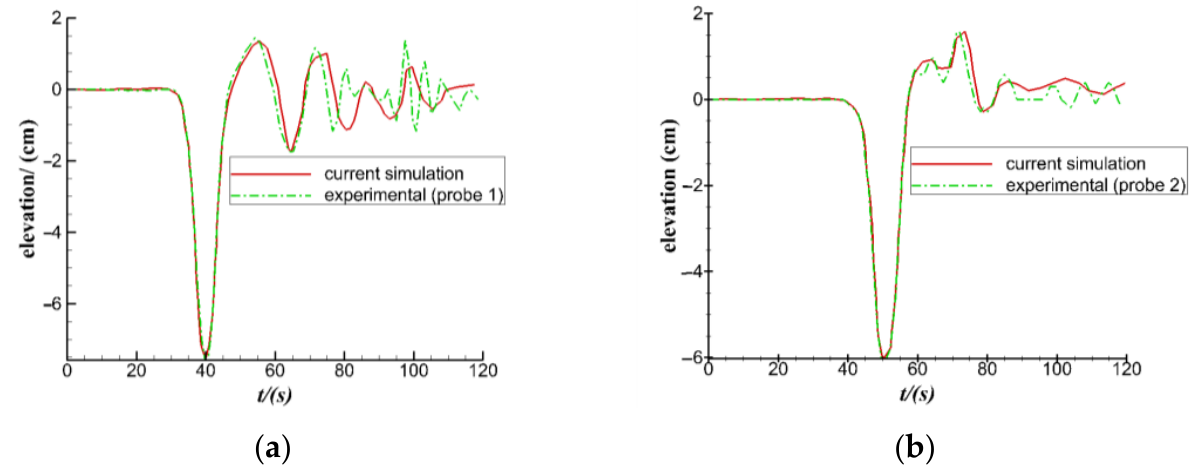
Figure 3. Validation results: ( a ) probe 1, ( b ) probe 2.